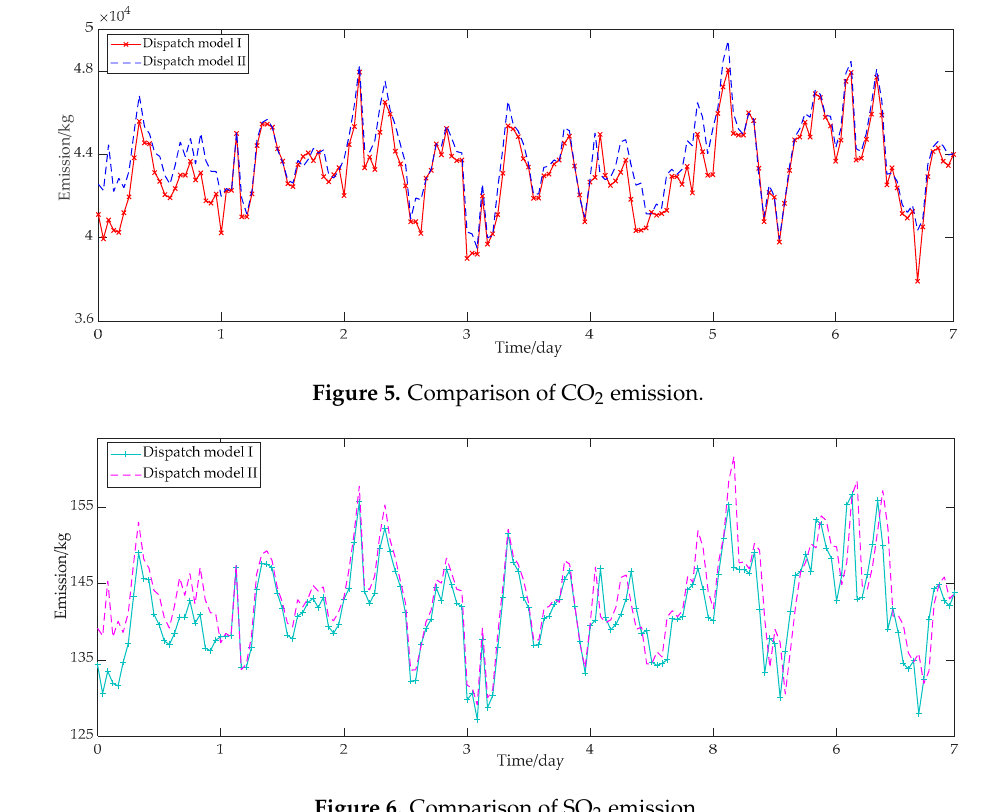
Figure 6. Comparison of SO 2 emission.